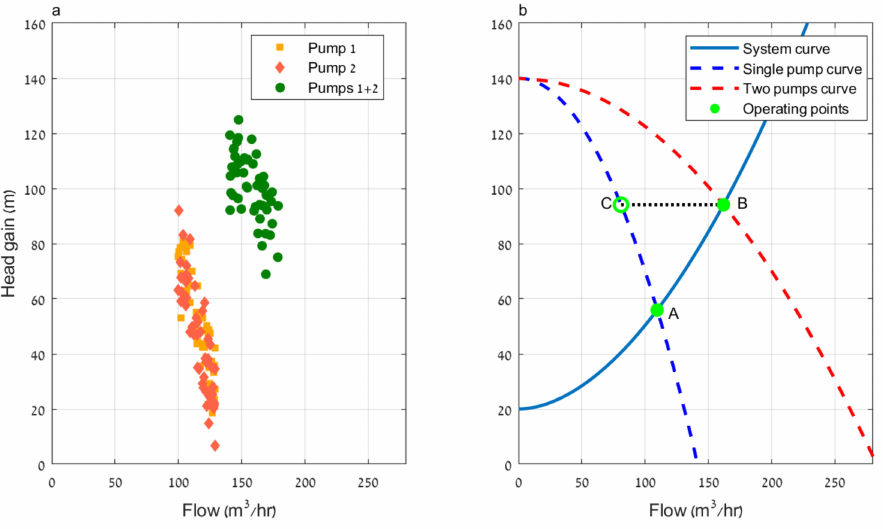
Figure 2. Two pumps operating in parallel ( a ) SCADA data ( b ) pumps and system